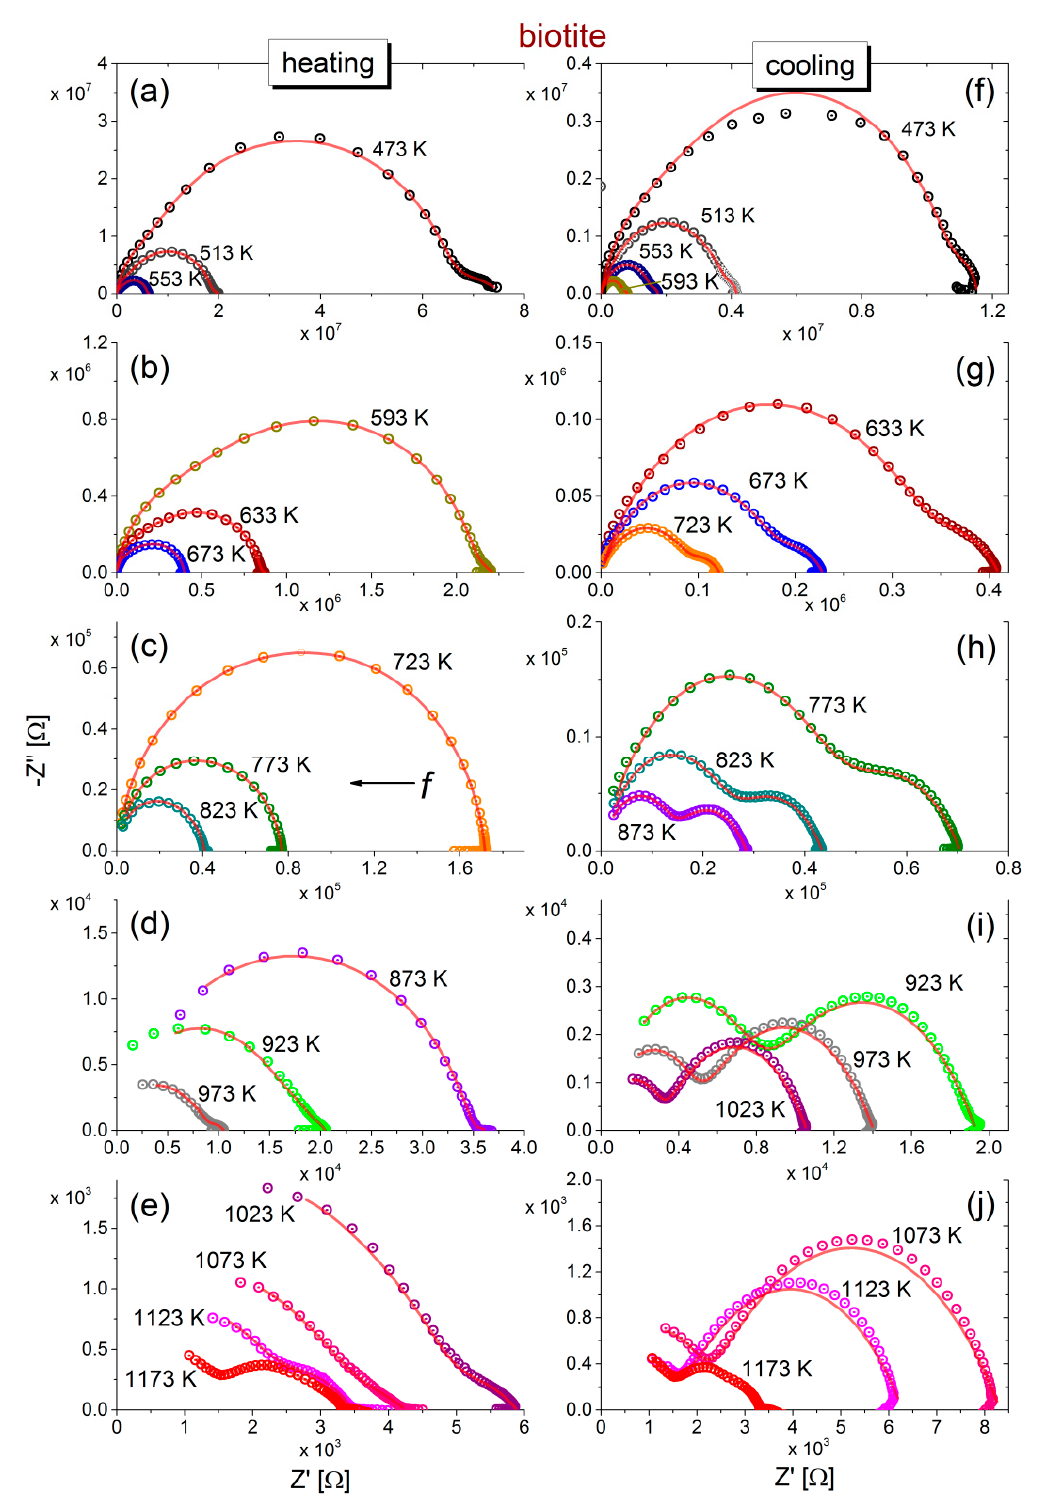
Figure 1. Cole-Cole plots of impedance ( − Z’’ vs. Z’) during the heating from 473 to 1173 K ( a – e ) and subsequent cooling ( f – j ) to 473 K of biotite mica sample. Experimental data are shown with open circles. Frequency increases from right (10 − 2 Hz) to left (10 6 ) Hz. The solid (red) lines correspond to fitting with an equivalent circuit. Note the different scales that are used in each plot of the heating- cooling cycle.